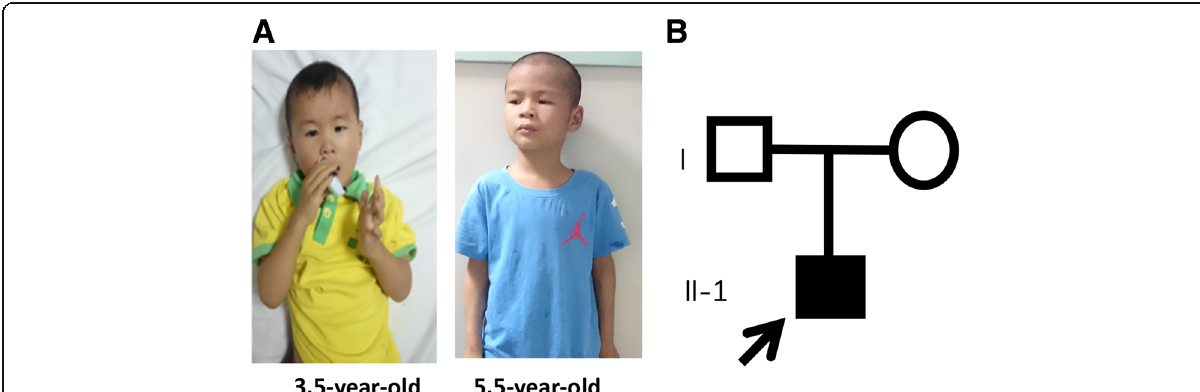
Fig. 1 Photographs of the affected boy and the pedigree of his family. ( a ) Facial appearance of the child at 3.5 (left panel) and 5.5 (right panel) years old, respectively. ( b ) The filled square represents the affected proband, empty symbols represent unaffected individuals, square represents male; the circle, female